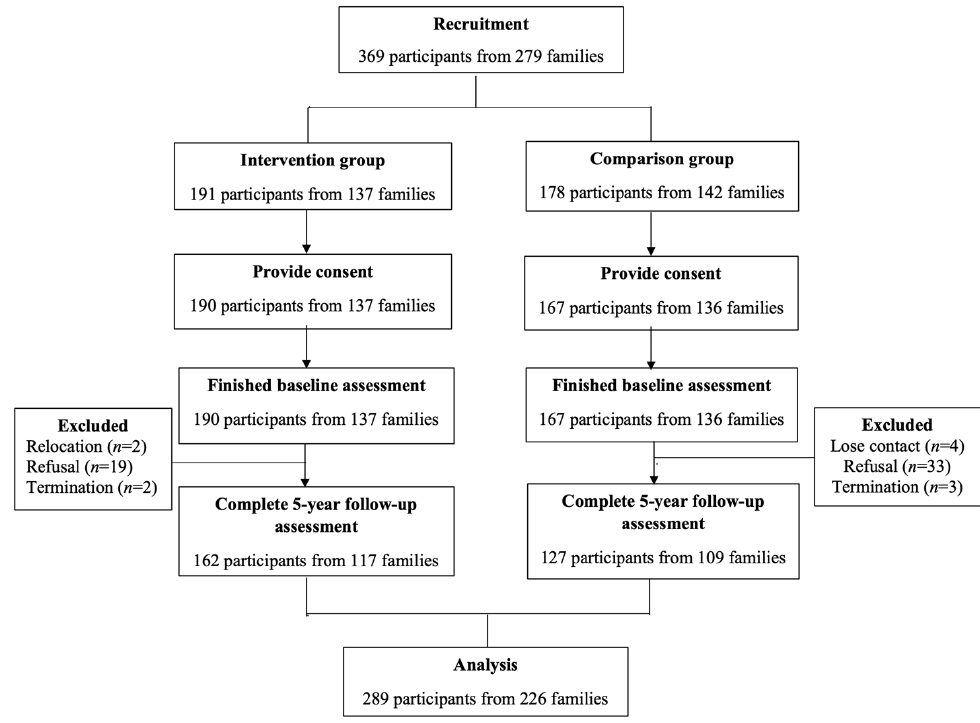
Figure 1. Subject fl owchart.